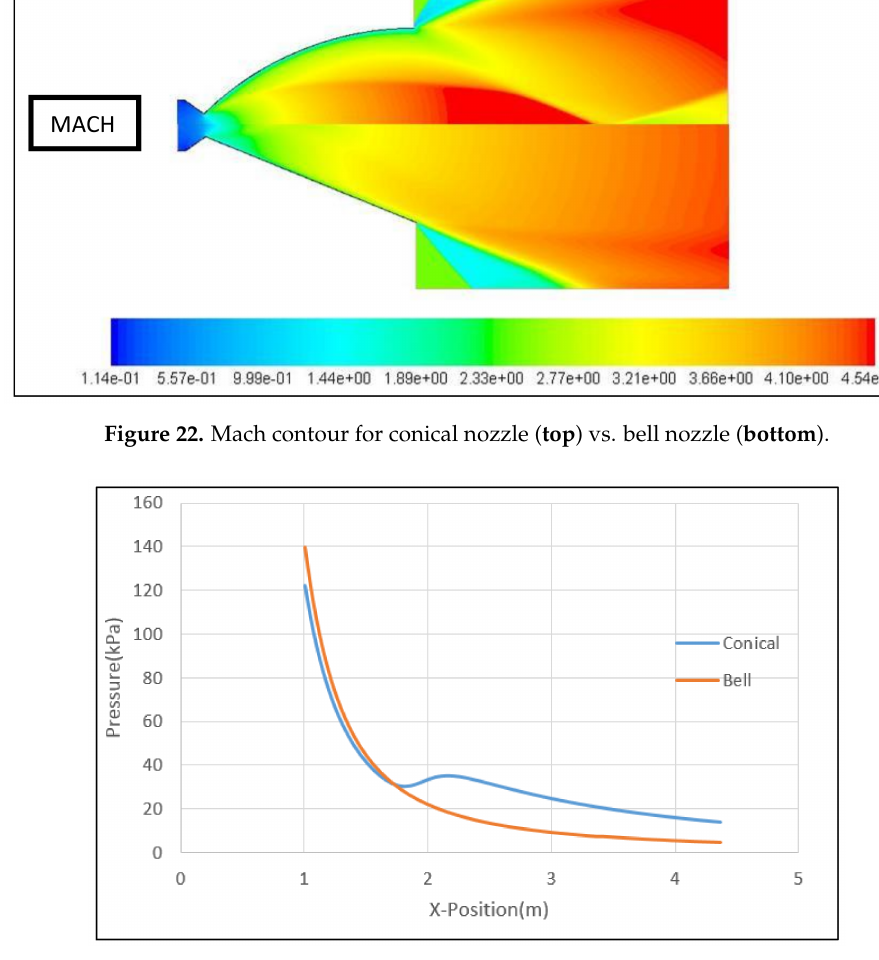
Figure 23. Pressure across the divergent